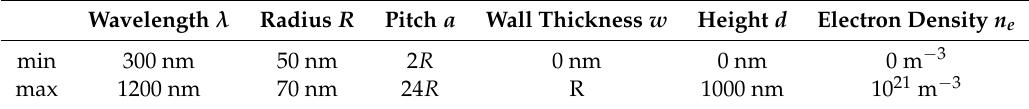
Table 1. Range of different geometrical parameters and illumination conditions under